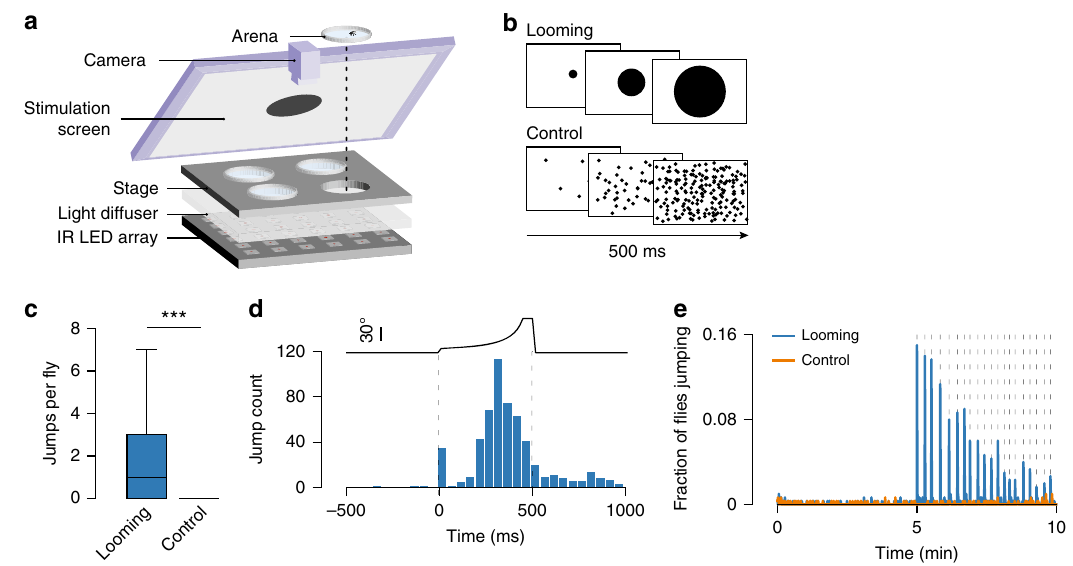
Fig. 1 - Flies jump in response to repeated looming. a Schematic of behavioral assay. b Schematic of visual stimuli, 300 fl ies were tested in each condition. c Number of jumps detected per fl y during the 5 min stimulation period. Center line, median; box limits, upper (75) and lower (25) quartiles; whiskers, 1.5x interquartile range. d Jump timing within a 1 s window around looming stimuli. Dashed lines indicate looming onset and offset. Top, size of looming disk (visual angle). e Proportion of fl ies jumping throughout the 10 min session. Dashed lines indicate stimulus presentations. *** denotes p <